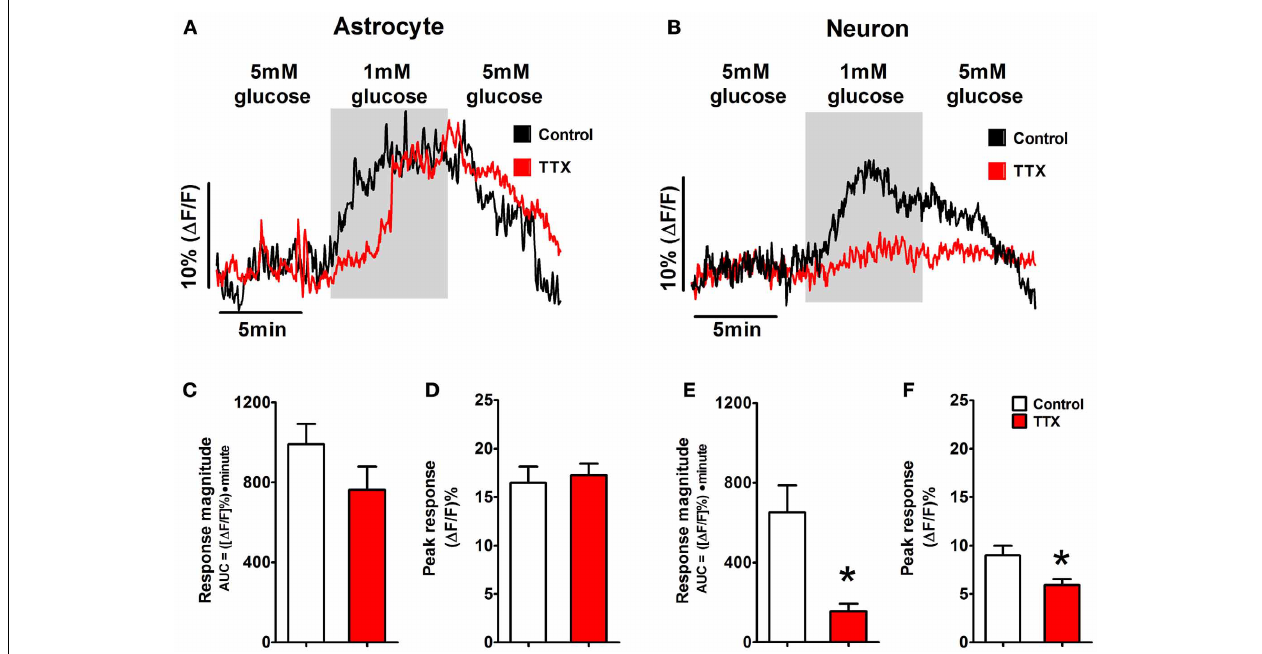
FIGURE 5 | Astrocytic glucodetection is independent of neuronal glucodetection. Mixed fields of NST-astrocytes and neurons were exposed to 1mM glucose concentrations with and without the presence of TTX in the perfusion bath. (A) The response of NST-astrocytes to a low glucose challenge is shown by black trace. The presence of 1 µ M TTX did not effectively alter the astrocytic response (red trace). In contrast, (B) the response of NST-neurons to a 1mM low glucose challenge was nearly abolished in the presence of bath TTX (black trace = control condition; red trace = TTX condition). Specifically, TTX did not produce any statistically significant changes in astrocytic (C) response magnitude or (D) peak response to low glucose